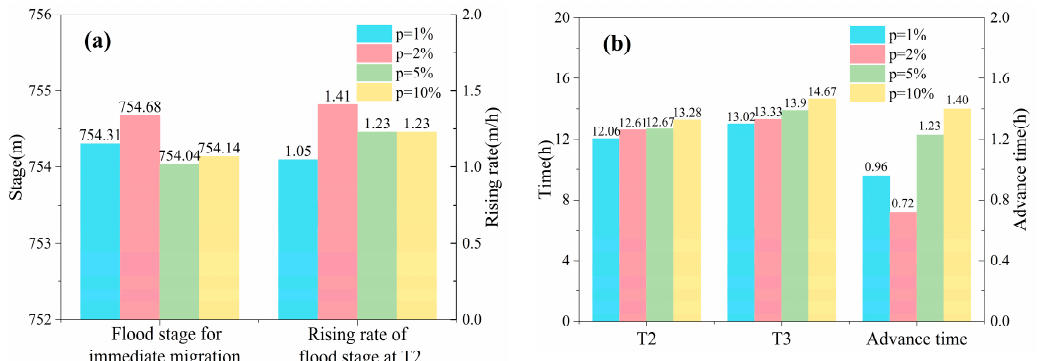
Figure 10. The average of early warning indicators under different return periods of rainfall: ( a ) the rising rate and the corresponding flood stage, ( b ) the advance time for early warning.